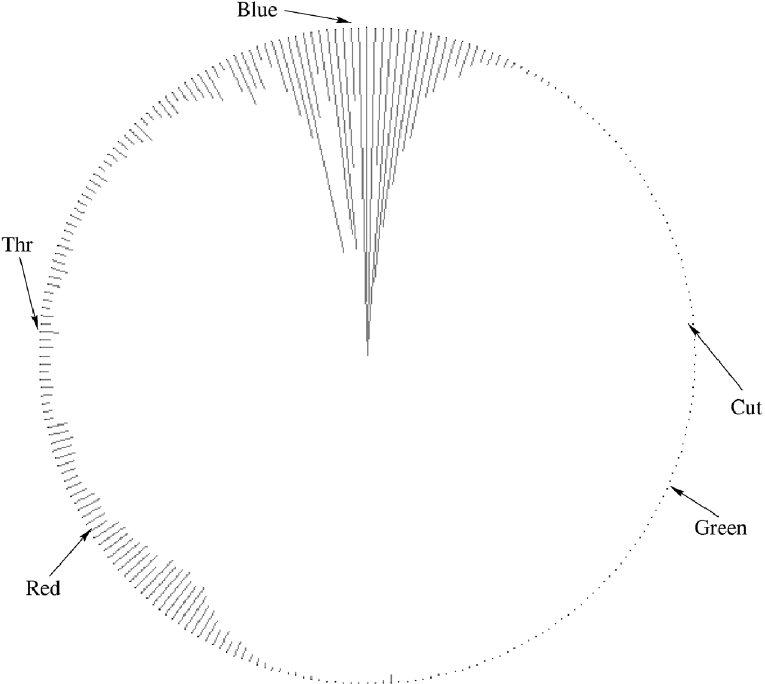
Fig. 7. PCH histogram for nuclei in specimen. The ‘cut’ and ‘threshold’ levels, respectively, are defined by the stored